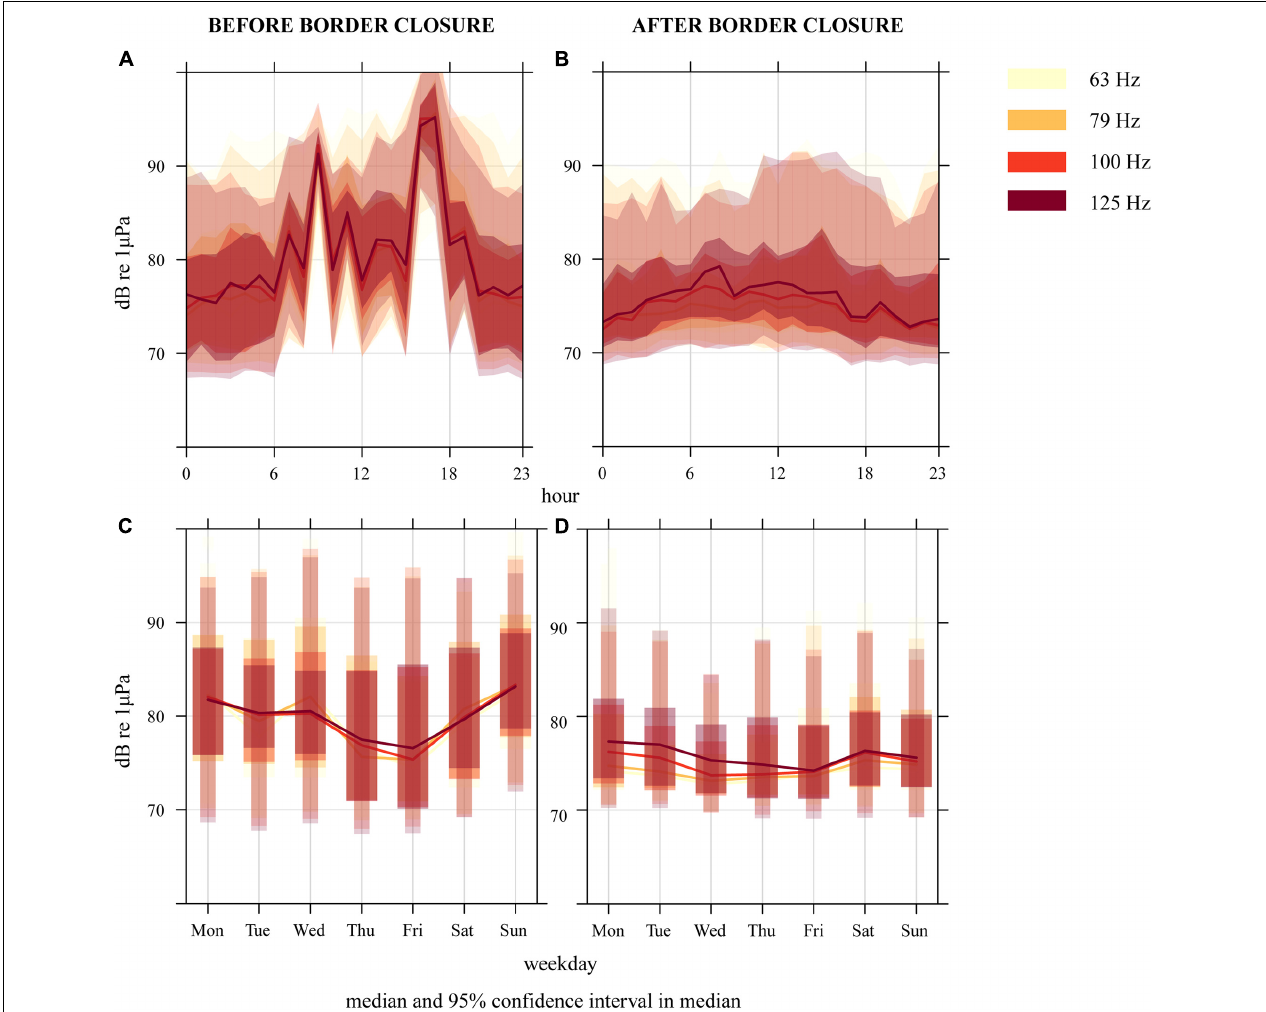
FIGURE 5 | Sound pressure levels in the hourly median 63–125 Hz 1/3 octave frequency bands at the Tisler reef from (A,C) 29 January–14 March 2020 and (B,D) 15 March–26 May 2020. The plot shows the 95% confidence intervals and the median (line), which are calculated through bootstrap simulation, providing the (A,B) diurnal and (C,D) weekly variation of noise